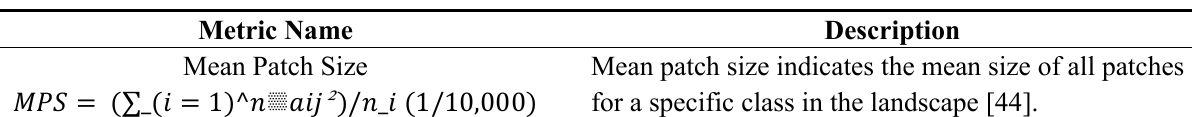
Table 2. Landscape fragmentation metrics used in this study using the Fragsats package